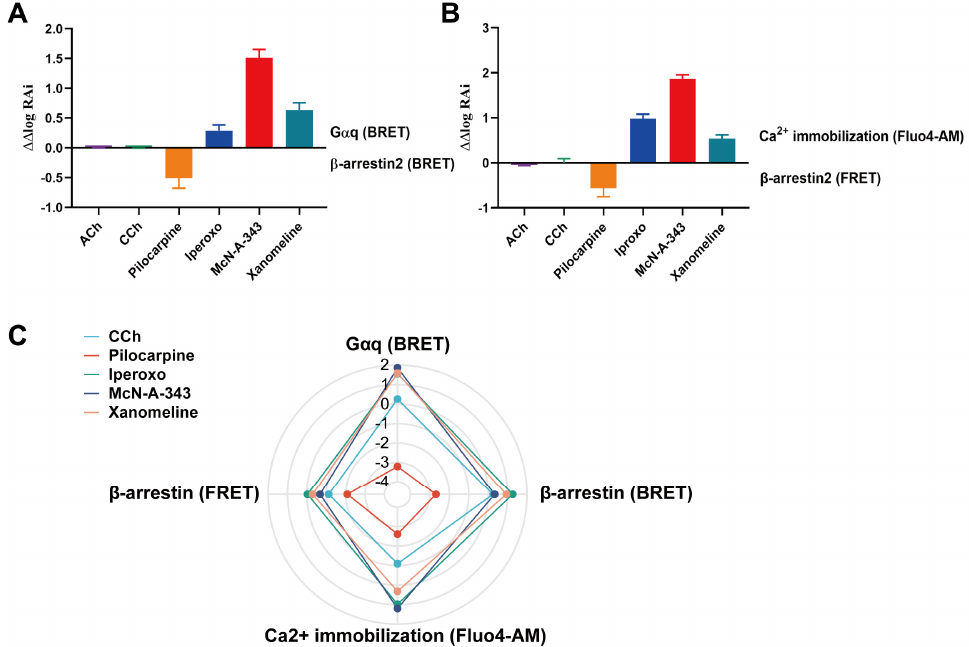
Figure 7. Evaluating the signaling bias of M1mAChR agonists. ( A ) Bias plots for ligands of M1mAChR using BRET assays. ( B ) Bias plots for ligands of M1mAChR obtained by commercial methods. ( C ) Comparing BRET assays and commercial methods in order identifying which agonist signal is preferred (relative intrinsic activity of each method). Data are means ± S.E.M. of 3–8 independent experiments performed in duplicate. Table 1. The relative intrinsic activity of agonists towards signaling pathways.